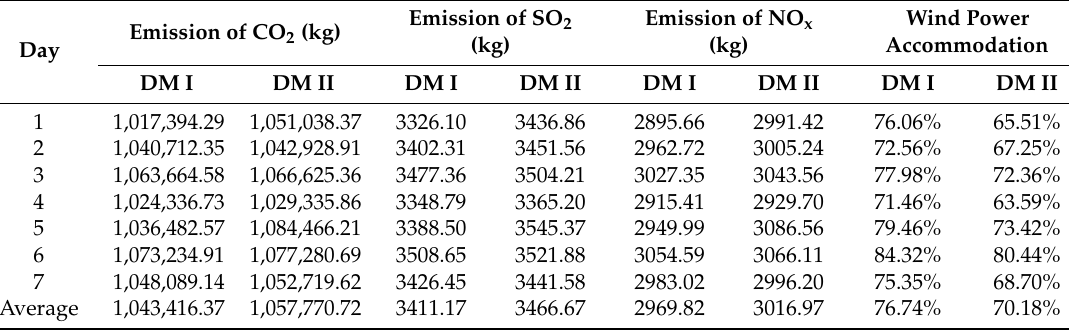
Table 2. Dispatching results of different